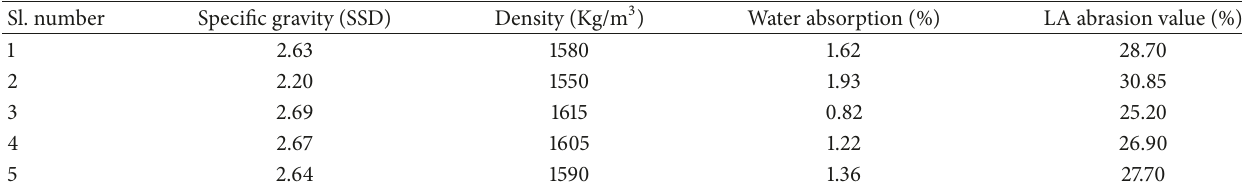
Table 2: Properties of natural stone aggregate.